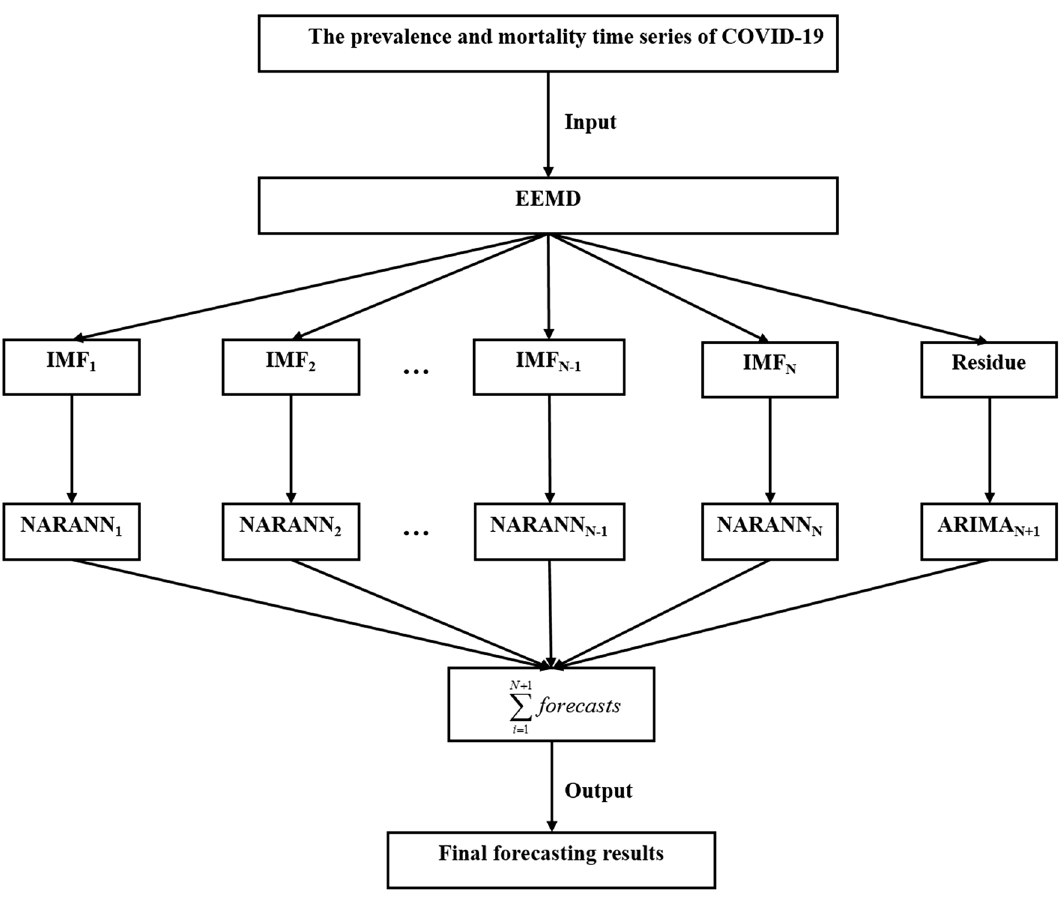
Figure 1. Flow chart of the novel data-driven EEMD-ARIMA-NARANN mixture